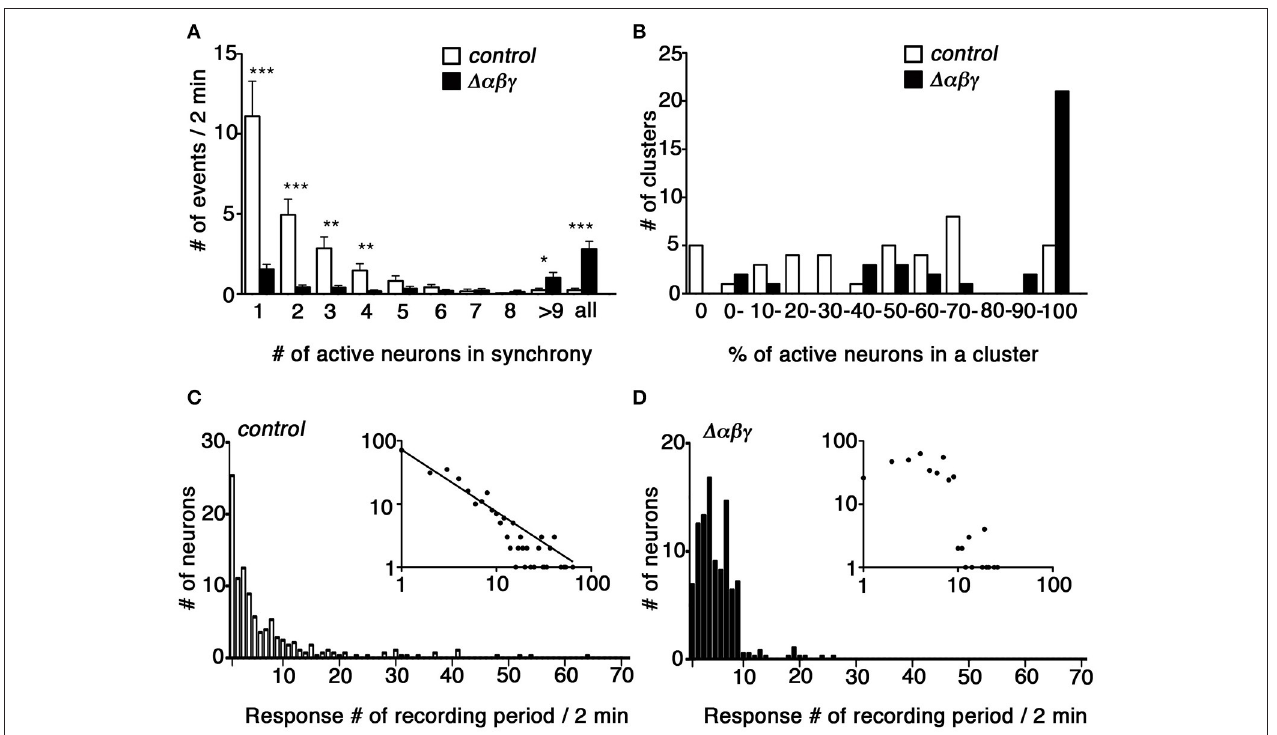
FIGURE 5 | Synchronous activity was higher in cultured ∆αβγ hippocampal neuronal networks. (A) Histogram showing the frequency of calcium responses in which the number of neurons indicated in each bin responded in synchrony. Events when all neurons in a cluster responded in synchrony were compiled in the right-most “all” column. Error bars represent SEM, *** P < 0.0001, ** P < 0.005, * P < 0.05 by Mann-Whitney U -test, n = 40 control (white) and 35 mutant (black) clusters for each of six independent cultures. (B) Histogram showing the percentage of active neurons in each cluster analyzed. The numbers in each bin indicate the percentage of active neurons and correspond to the lower limit range covered by each bin: 0 and 100% were assigned separate bars, and the range between 0 and 100% was divided into 10 bins. N = 40 clusters for control (white), and n = 35 mutant (black) clusters for six independent cultures each. (C,D) Histograms showing the distribution of the number of neurons with the calcium response frequency observed during a 2-min recording period. Insets show the same data plotted in log-log coordinates. A power-law distribution with a slope of − 0.98 is indicated in the control graph. N = 280 control neurons and 385 mutant neurons for six independent cultures. Data derived from the Pcdh αβγ + / + :TG taf 7 and Pcdh αβγ del / + :TG taf 7 genotypes were used as